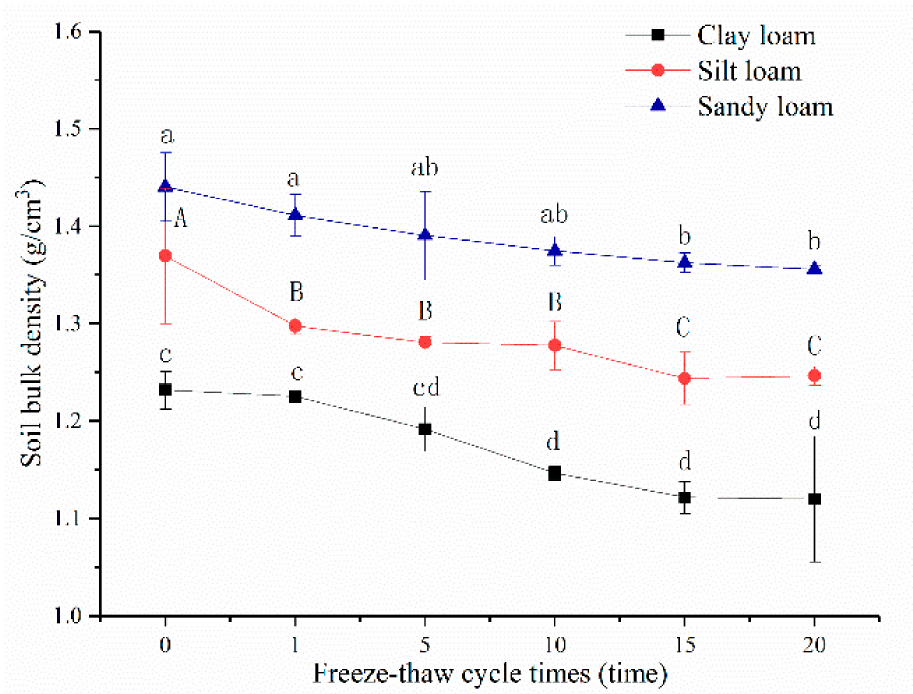
Figure 3. Relationships between soil bulk density and freeze-thaw cycles of three soils. Note: The letters indicated whether the differences in the test results were significant or not. “a, b” stands for sandy loam, “A, B” stands for silt loam, “c, d” stands for clay loam. And different letters indicate a significant difference of test results among the different freeze-thaw cycles and soils at the 0.05